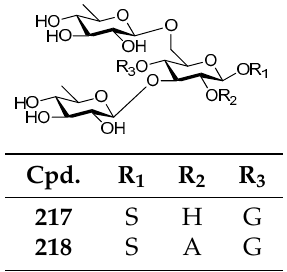
Figure 35. Structures of compounds 217 – 218 .